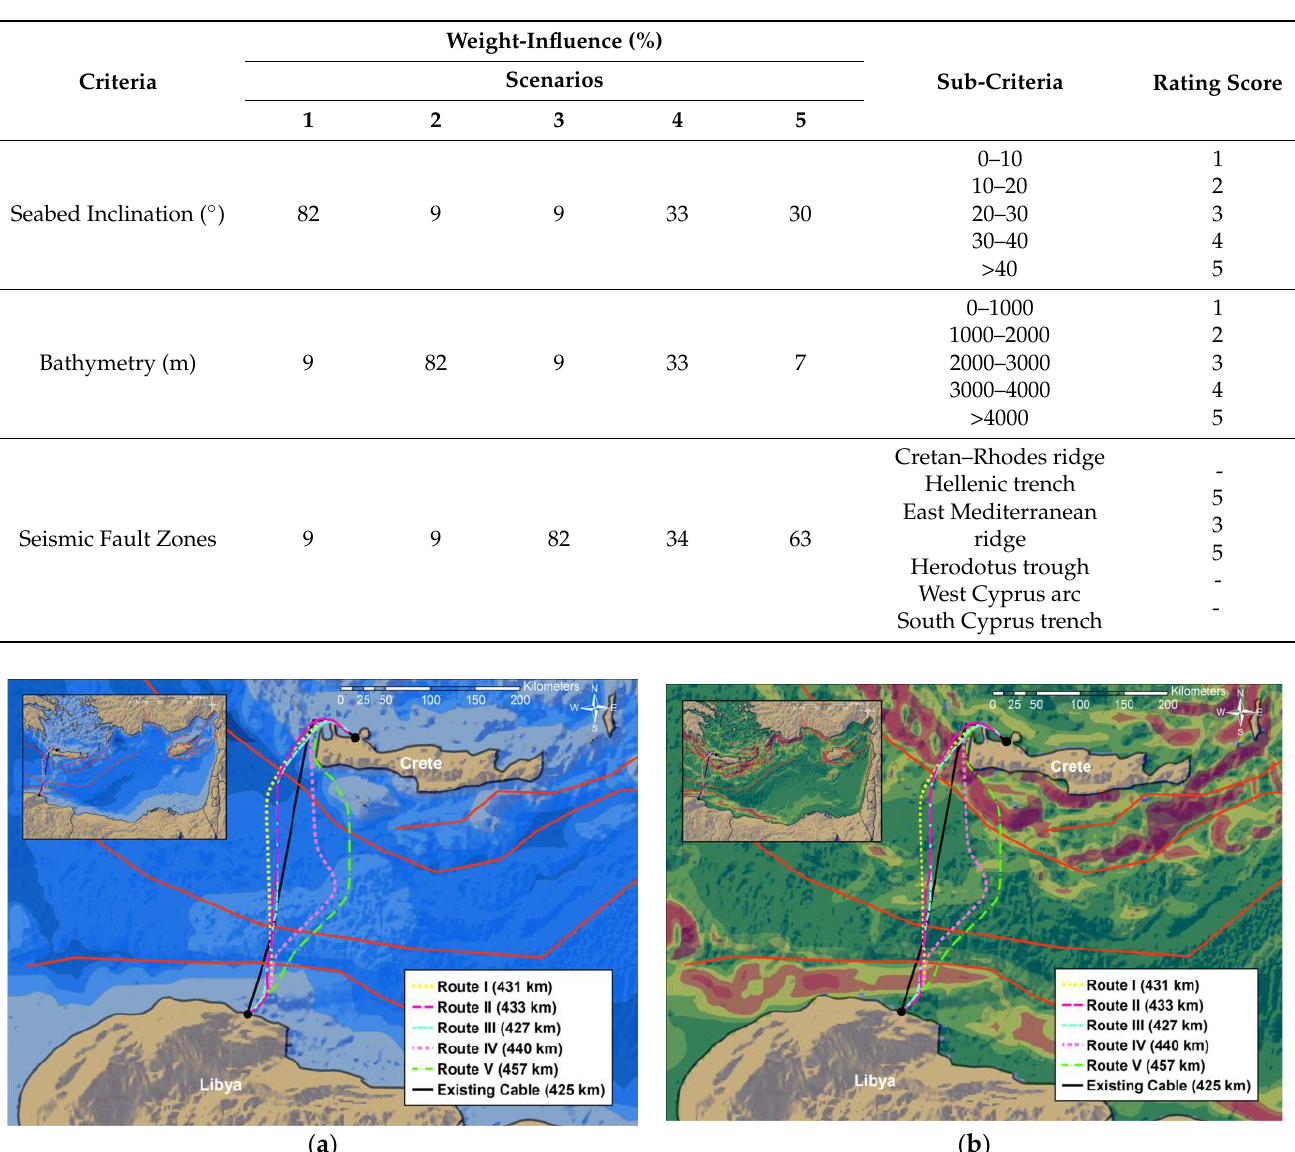
Table 3. Weight-influence and rating score of each of the adopted criteria and sub-criteria for Case Study 1.